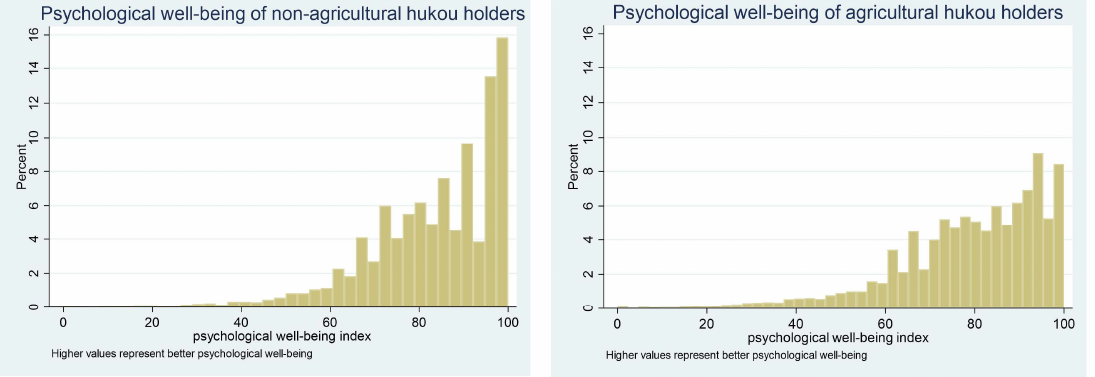
Figure 1. Distribution of the psychological well-being index among non-agricultural and agricultural hukou holders.